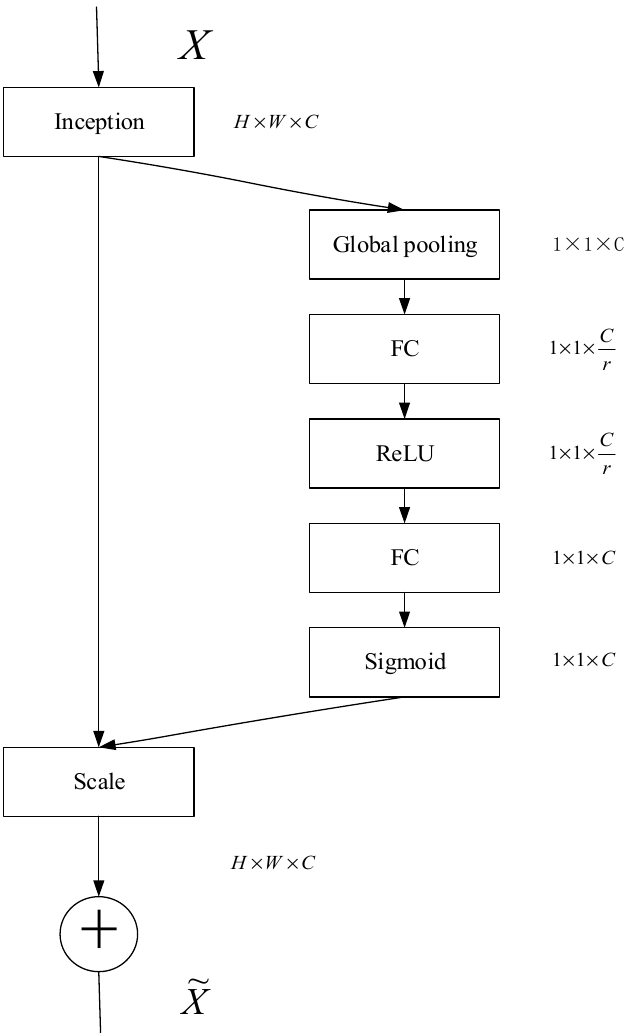
Figure 6. The combined structure of the SE module and the Inception structure.